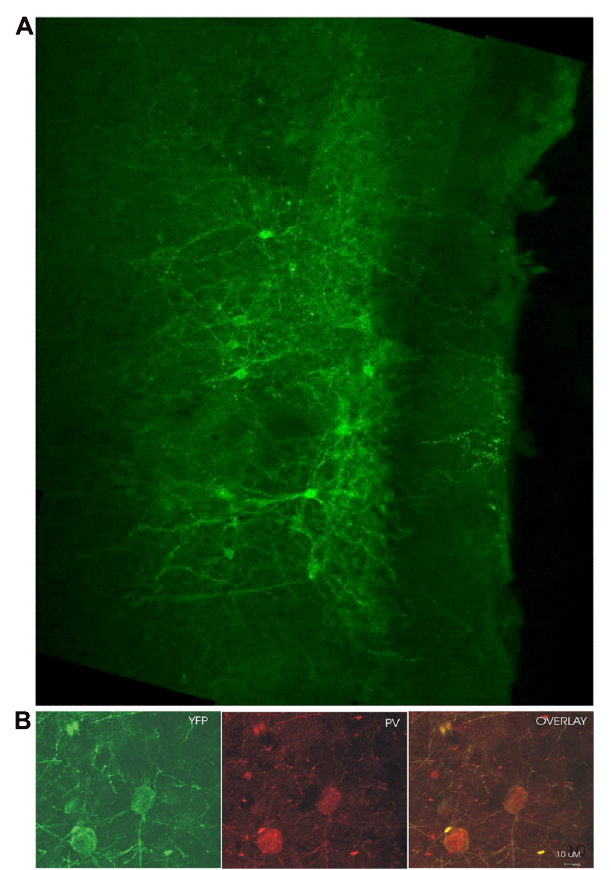
FIGURE 1 | ChR2 expression in PV + cells 4 weeks post-infection. (A) YFP fluorescence in a medial PFC coronal section from an infected mouse (medial/pial surface is to the right, dorsal toward the top of the page) . (B) YFP labeled cells double-stained for parvalbumin (PV).YFP labeling in green on the left, PV immunoreactivity shown in red in the middle, overlay ofYFP and PV labeling on the right.Yellow suggests colabelling of PV + cells withYFP, demonstrating ChR2 expression in cells which are immunoreactive for PV.